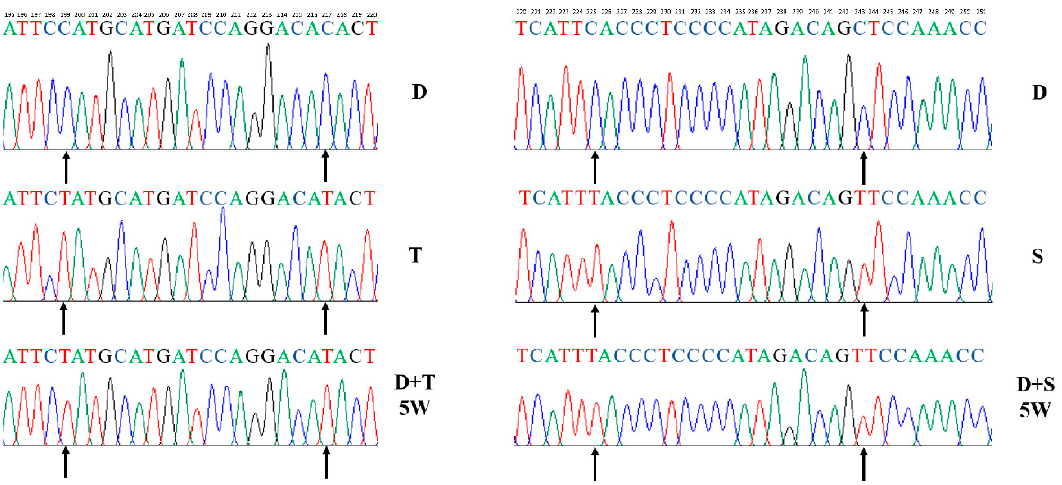
Figure 1. Sequence verification in the generation of different cybrid cells. D, T, and S harbor characteristic sequence signatures within the D-loop region. The endogenous mtDNAs (D) were no longer detectable in the fifth week (D+T/5W, D+S/5W). In cybrid cells, the acronym D denotes a common nucleus of DF-1, and +T and +S represent the source of the mitochondria. 5W: cell culture for five weeks.